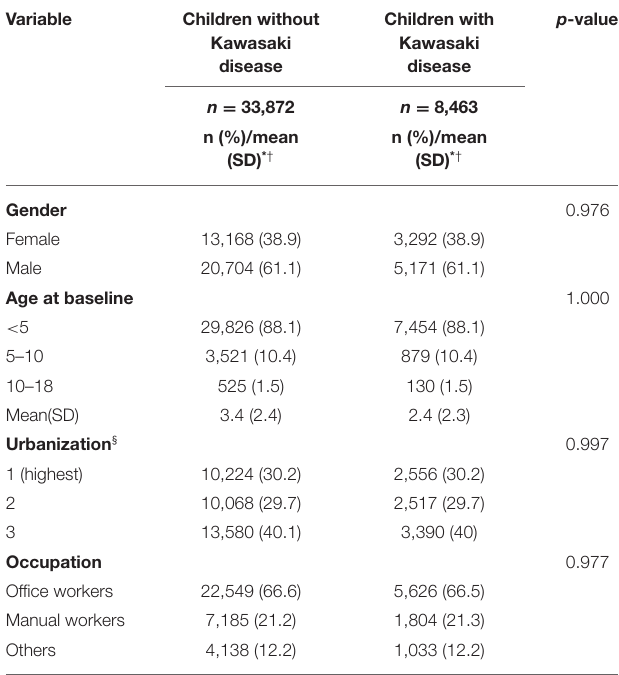
TABLE 1 | Demographic characteristics of patients with Kawasaki disease in Taiwan during